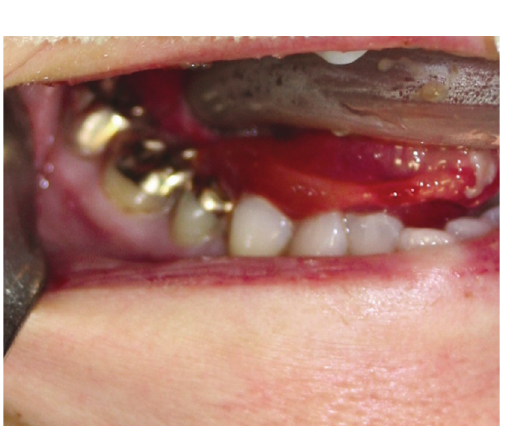
ETT appropriately entered the laryngeal opening (Figure